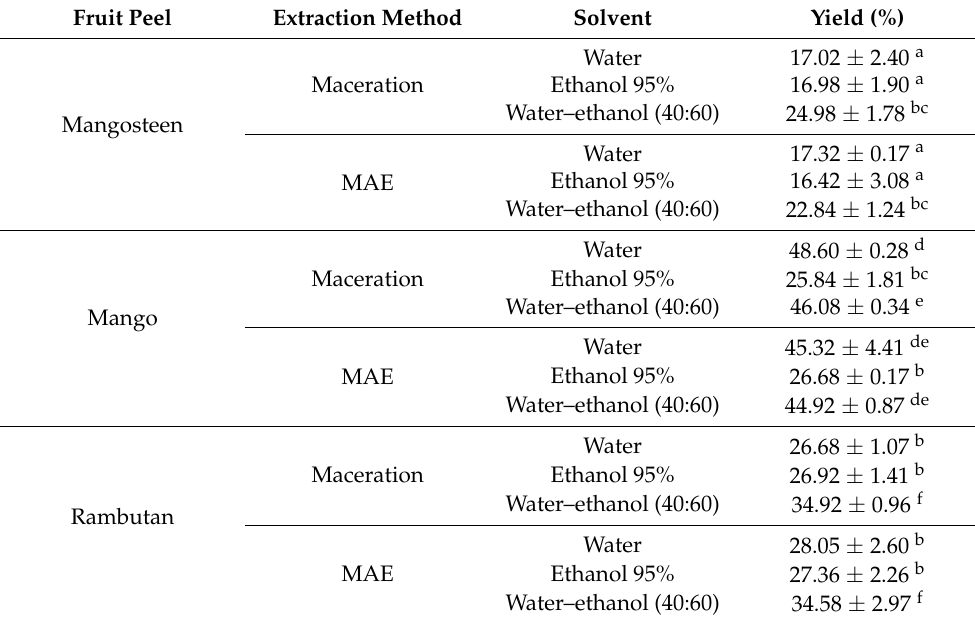
Table 1. The extraction yield (%) of each fruit